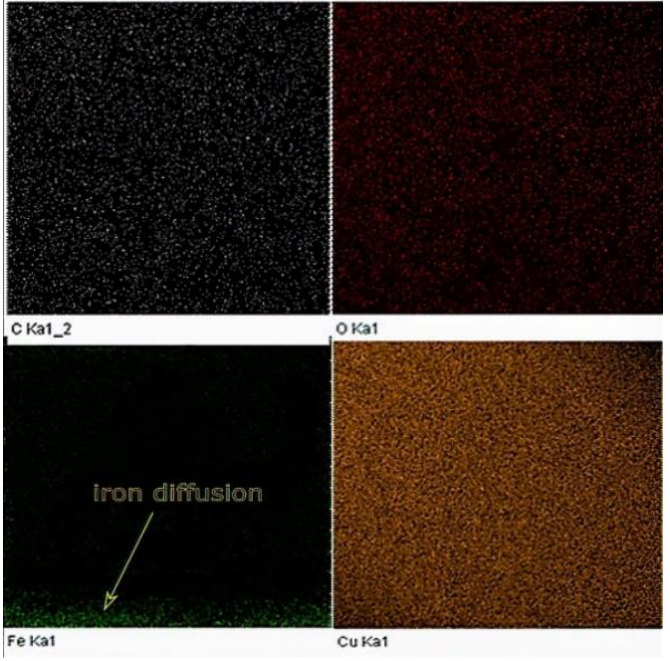
Figure 18. EDX map of the Cu sample built by L-PBF ( P = 370 W, v = 500 mm/s, h = 0.1 mm).